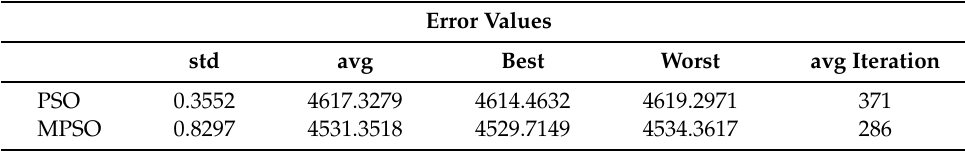
Table 3. Model identification performance of PSO and